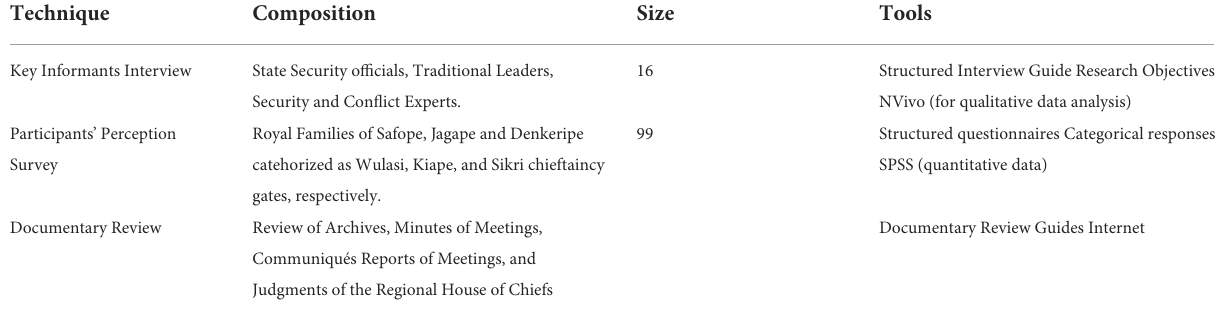
TABLE 1 Data collection instruments.